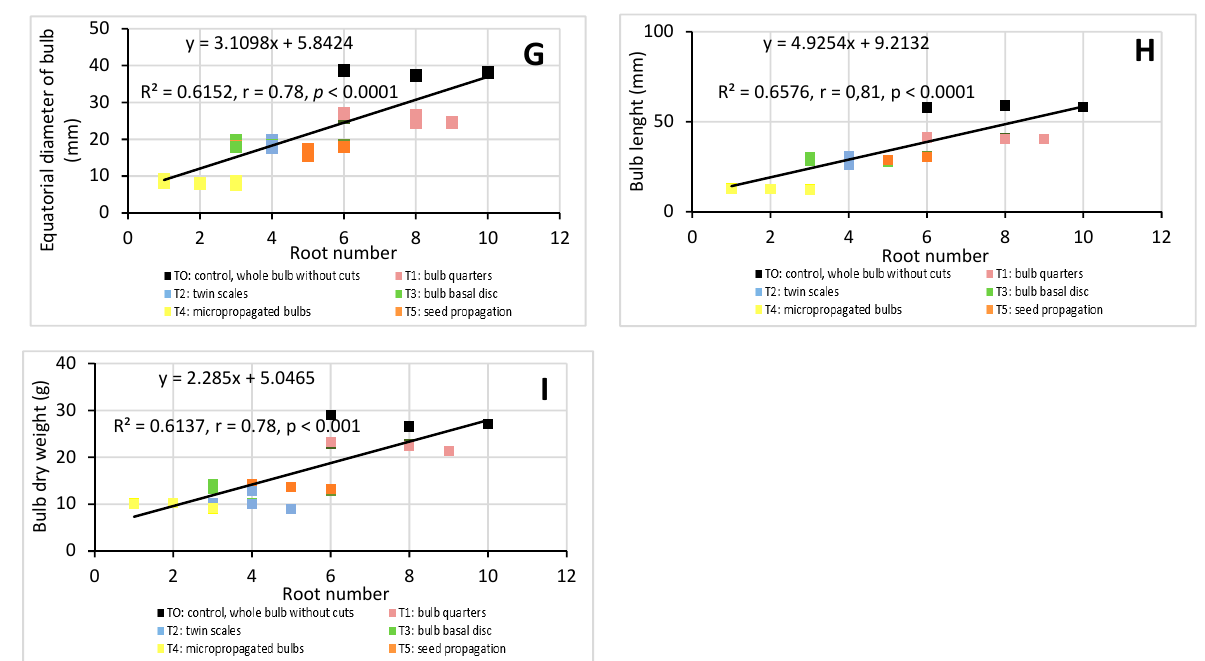
Figure 5. Linear correlation analysis: root length-equatorial bulb diameter ( A ), root length-bulb length ( B ), root length-bulb dry weight ( C ), root diameter-equatorial bulb diameter ( D ), root diameter-bulb length ( E ), root diameter-bulb dry weight ( F ), root number-equatorial bulb diameter ( G ), root number-bulb length ( H ), root number-bulb dry weight ( I ). Coefficient of determination (R 2 ) and Pearson’s correlation coefficient (r) are reported. p < 0.05 indicate that the linear correlation is statistically significant.